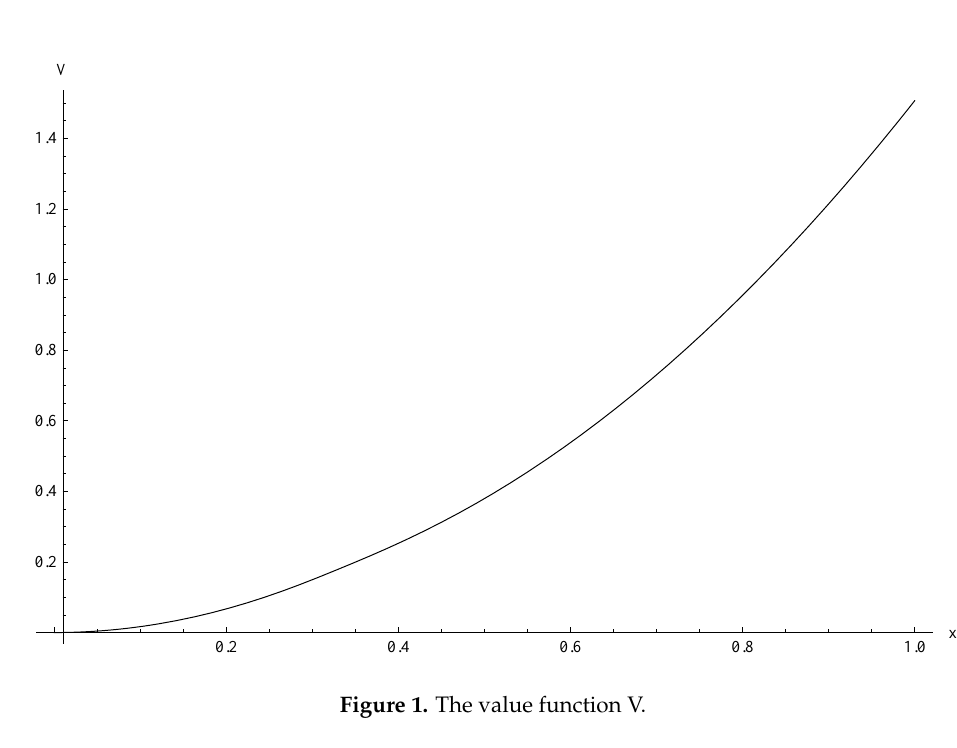
Figure 1. The value function V.